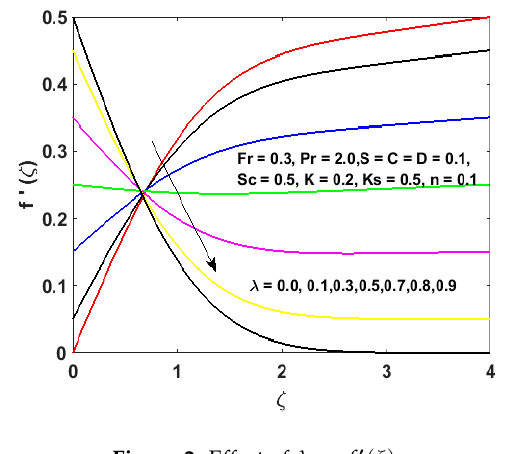
Figure 2. Effect of